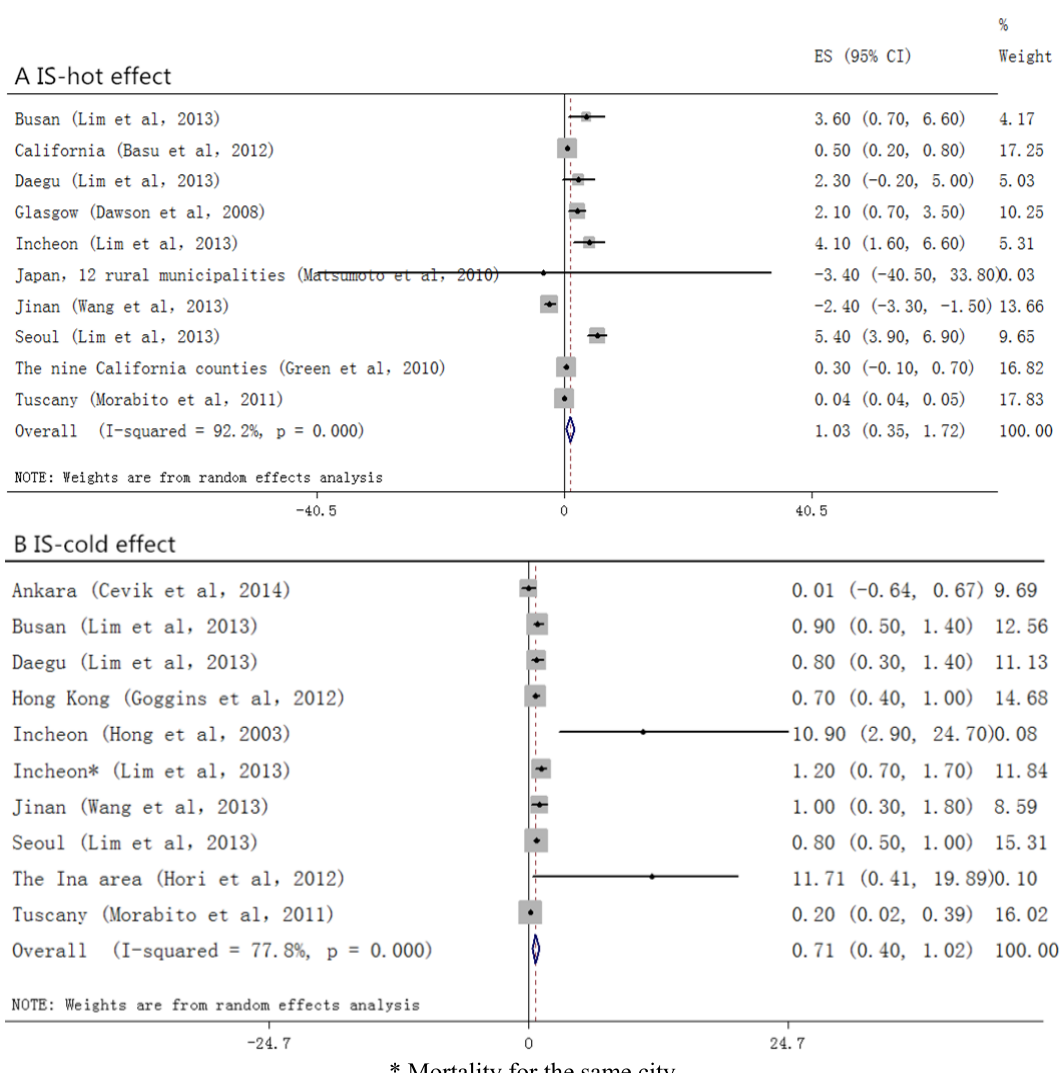
Figure 6. Forrest plots for relationship between the temperature change and IS. A and B stand for hot and cold effect,